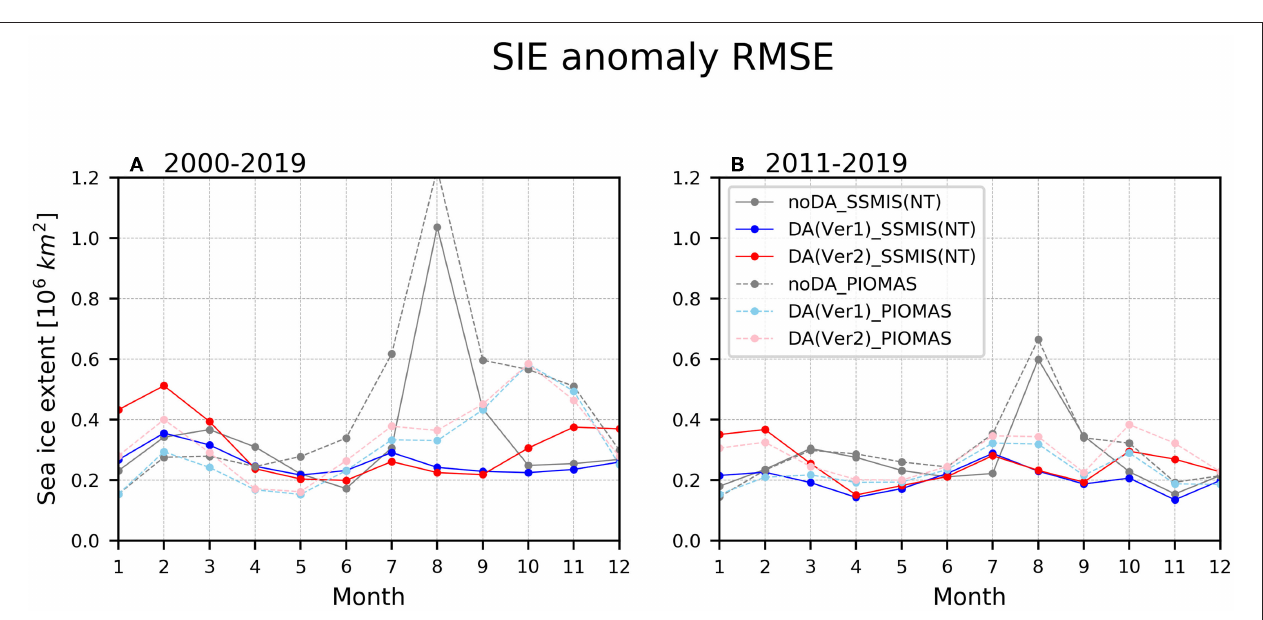
FIGURE 9 | The root-mean-square-errors with respect to the SSMIS NT (solid lines) and PIOMAS (dashed lines) of sea ice extent index ( 10 6 km 2 ) for noDA (gray), Ver1 (blue and skyblue), and Ver2 (red and pink) during 2000–2019 (A) and 2011–2019 (B)